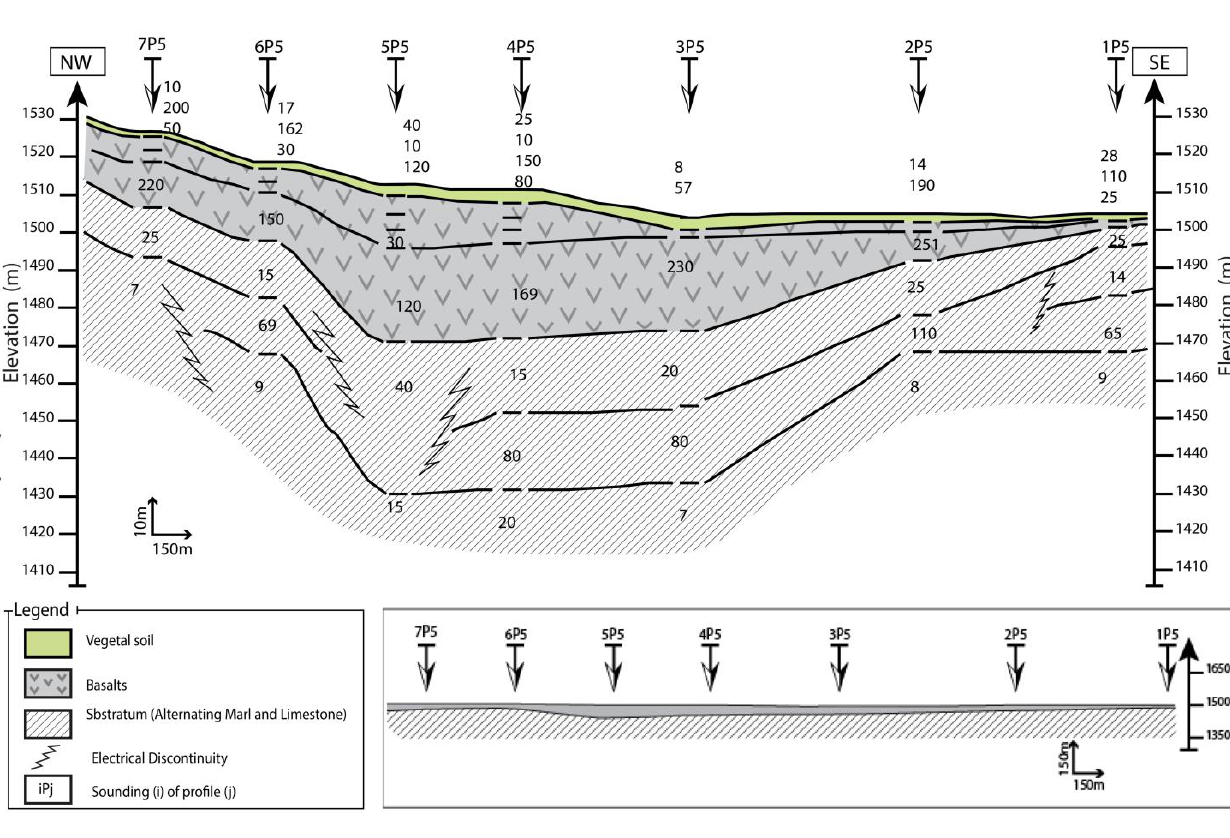
Figure 8. GS3 geoelectrical section of profile 5.